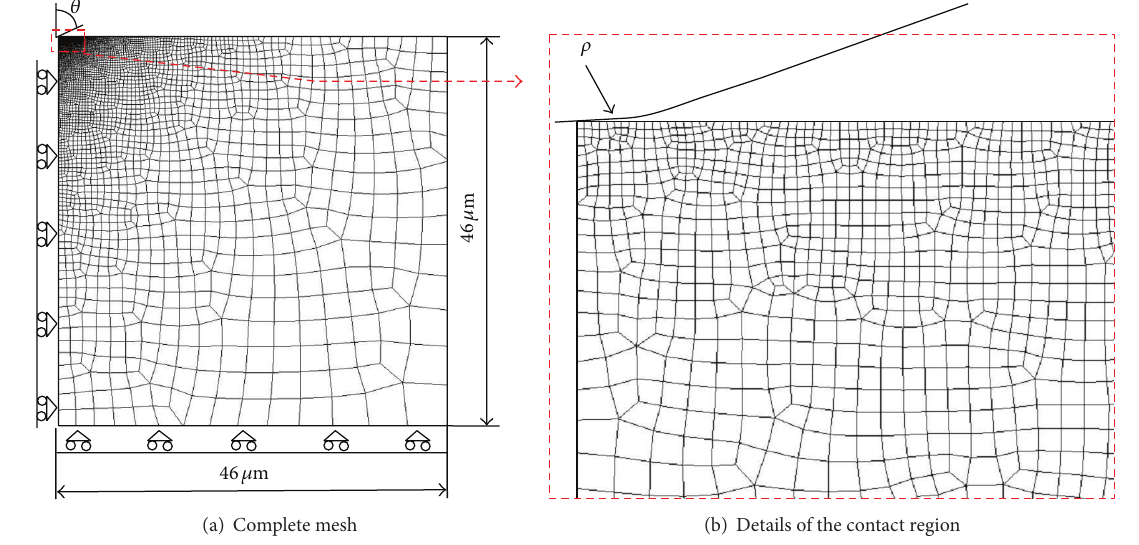
Figure 3: Finite element model used in 2D numerical simulation.